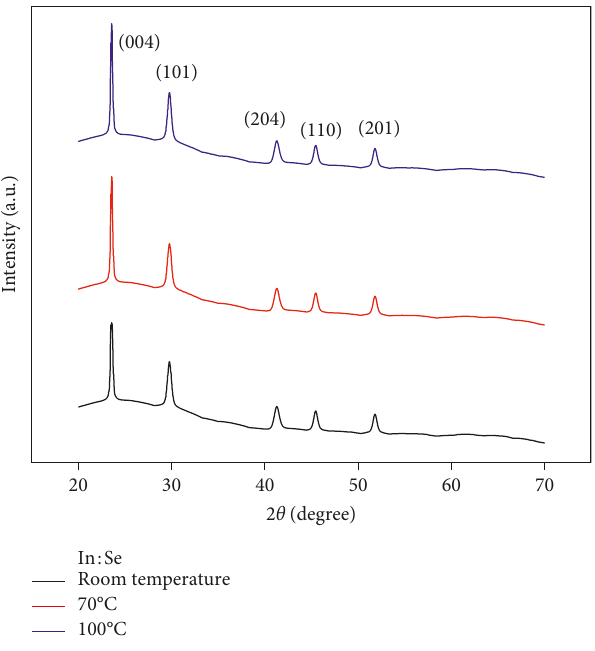
Figure 4: XRD patterns of InSe thin films at different annealing